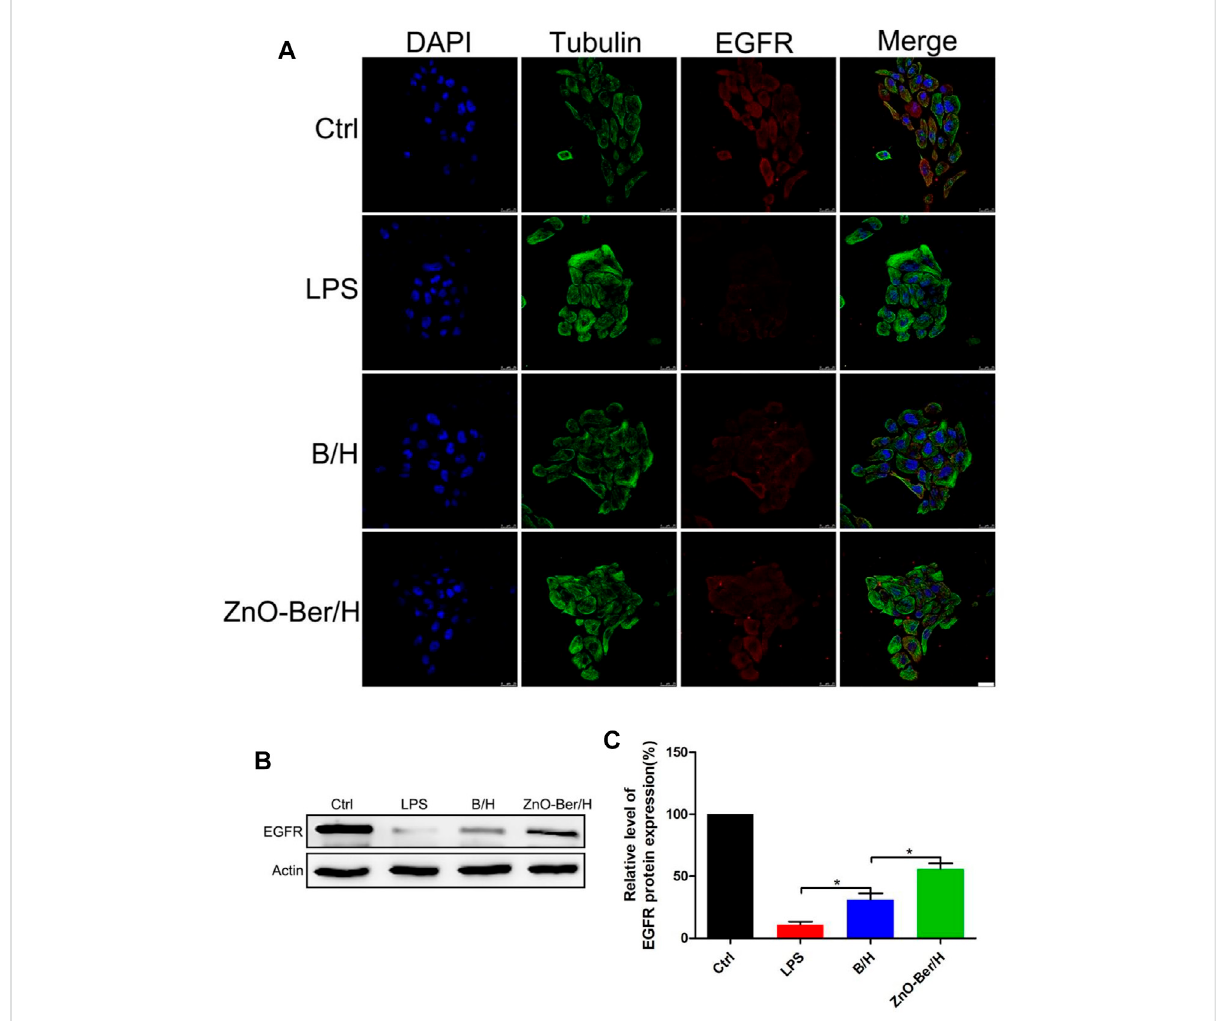
FIGURE 3 ProteinexpressionofEGFRinHaCaTbyImmuno fl uorescence stainingandWestern Blot. (A) Immuno fl uorescence stainingofEGFR expression ofHaCaT cells. (B) Western blot detection ofexpressionofEGFR proteins inHaCaT. (C) The expressionanalysis ofEGFR. Scalebar: 25 μ m.Statistical analysis: * p ≤